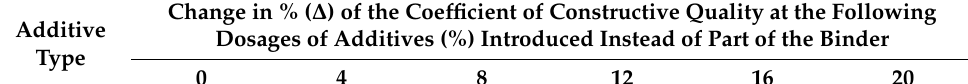
Table 11. Change in the coefficients of structural quality of non-autoclaved aerated concrete depend- ing on the type of additive and its dosage.